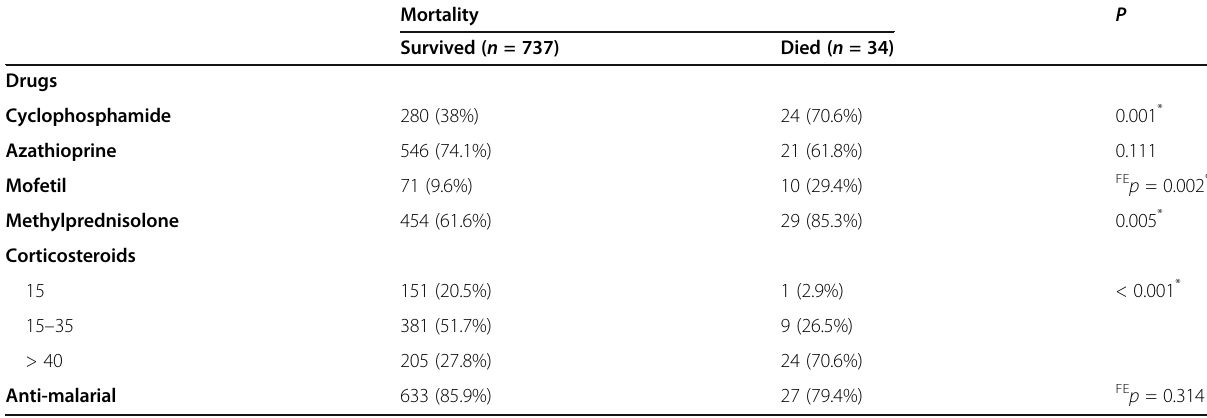
Table 4 Relation between mortality and drug therapy